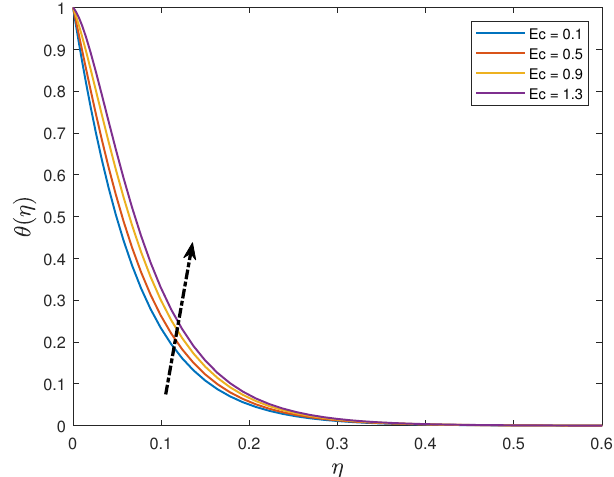
Figure 8. Influence of Ec on the nanofluid temperature.